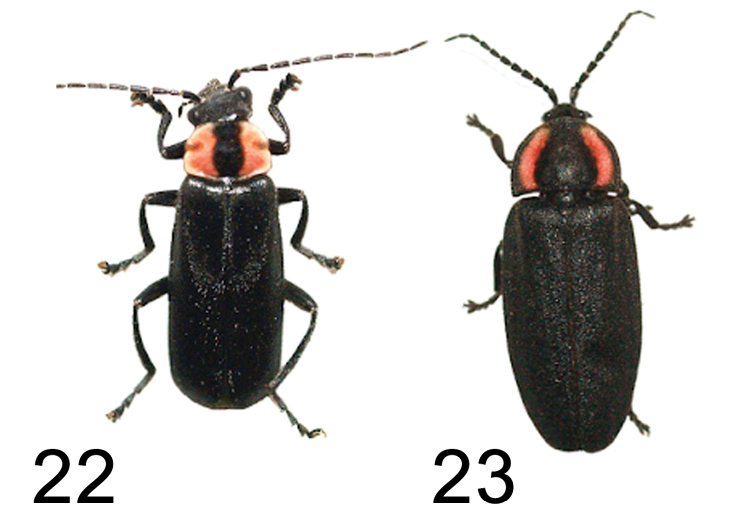
Mullerian mimicry with Coleoptera. 22Discodonbipunctatum (Cantharidae) 23Ellychniacorrusca (Lampyridae).